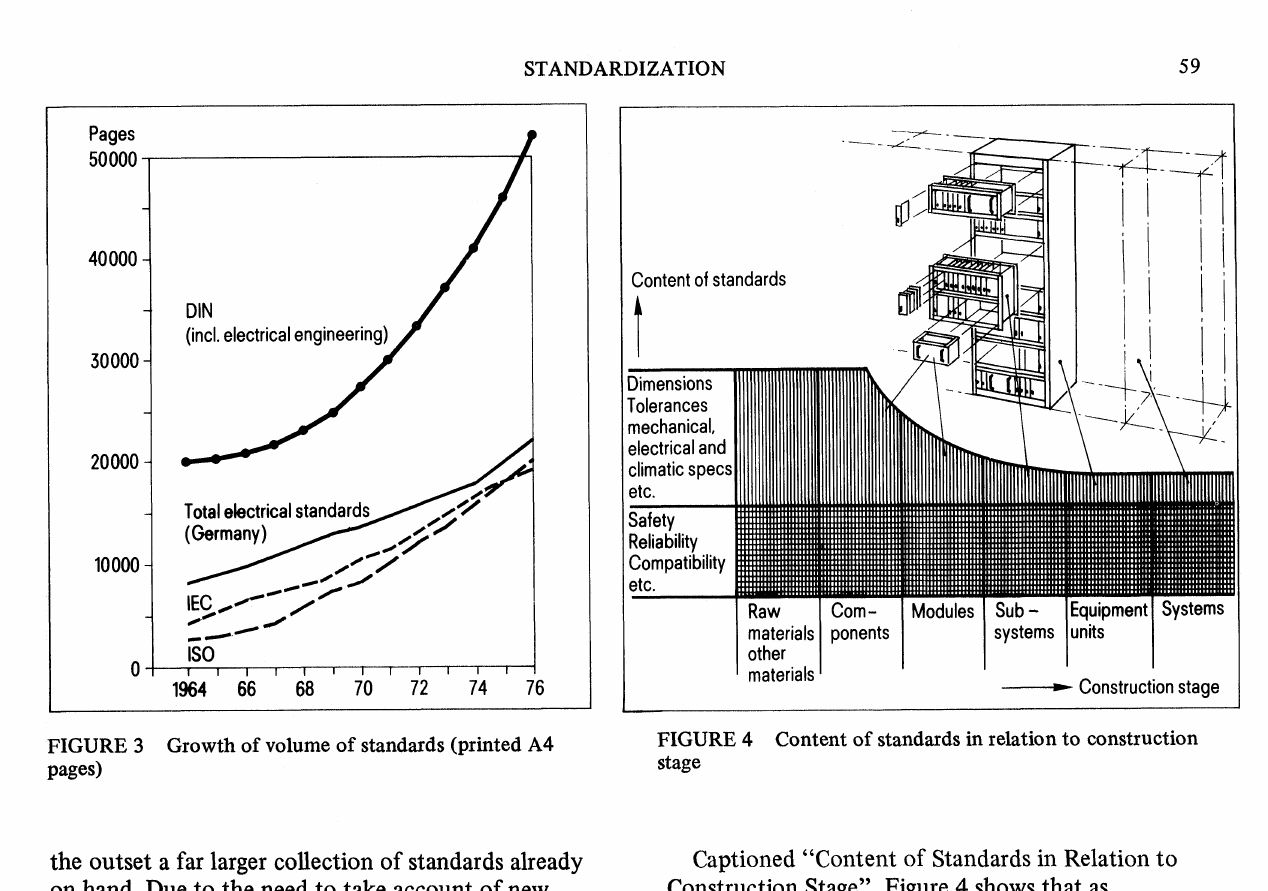
FIGURE 4 Content of standards in relation to construction